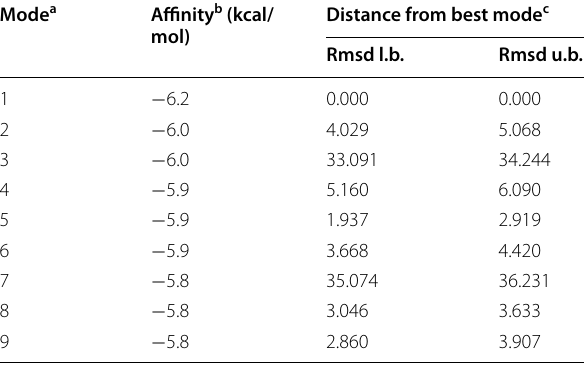
Table 1 Results of docking analysis in the AutoDock Vina software within the gridbox for CAT enzyme